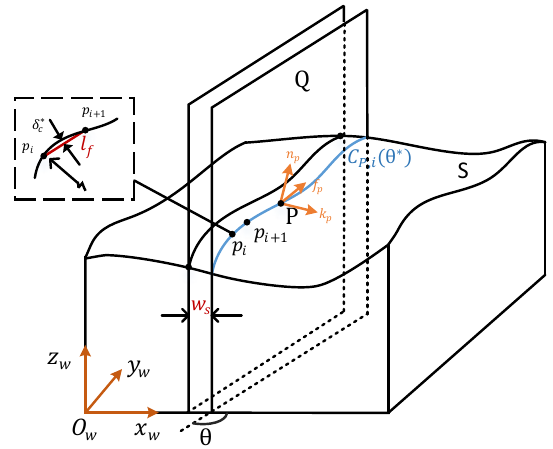
Figure 5. Iso-planar pattern NL path generation.